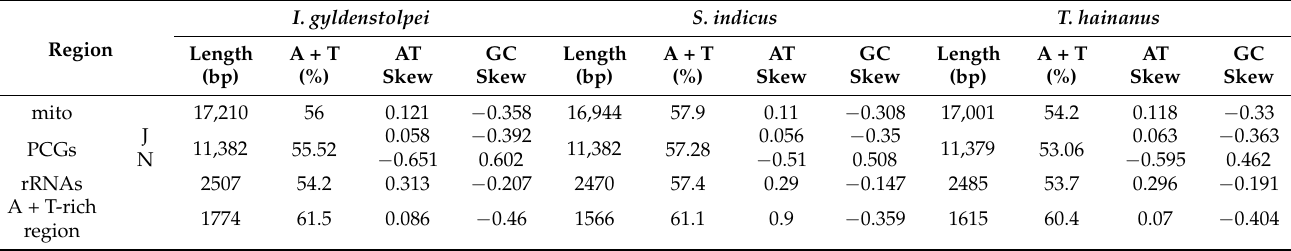
Table 2. Base composition of the mitochondrial genomes of the three